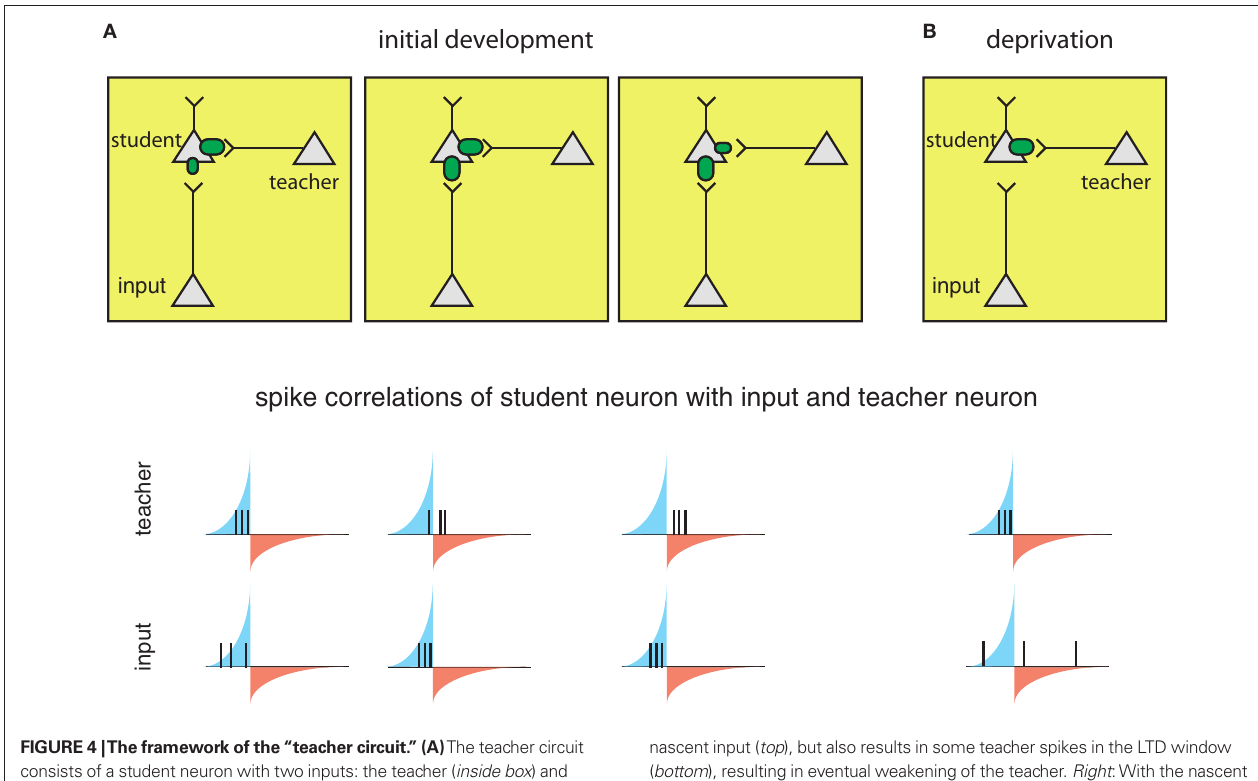
Figure 4 | The framework of the “teacher circuit.” (A) The teacher circuit consists of a student neuron with two inputs: the teacher ( inside box ) and nascent inputs to be learned ( inside box ). Left : Initially, the teacher has a strong connection ( top ), and its activity is paired with a weaker input, leading to spikes from both inputs falling in the potentiation window of STDP ( bottom ). The potentiating and weakening windows of STDP rule are indicated in blue and red shading. Middle : The pairing of the teacher and nascent input strengthens the